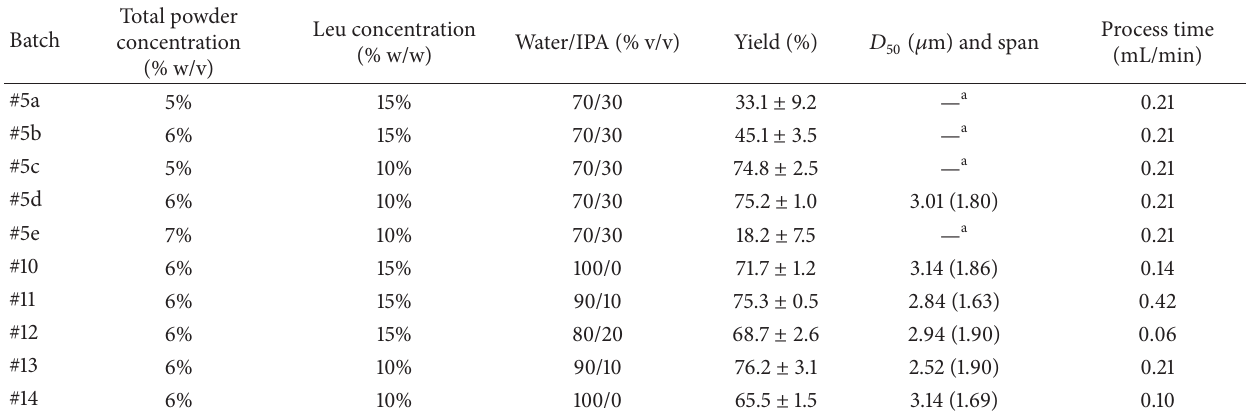
Table 3: Process parameters and physical characteristics of Klys/leu particles sprayed through a surfactant treated nozzle (70 ∘ C, 4 𝜇 m nozzle): liquid feed composition, yield, and dimensional